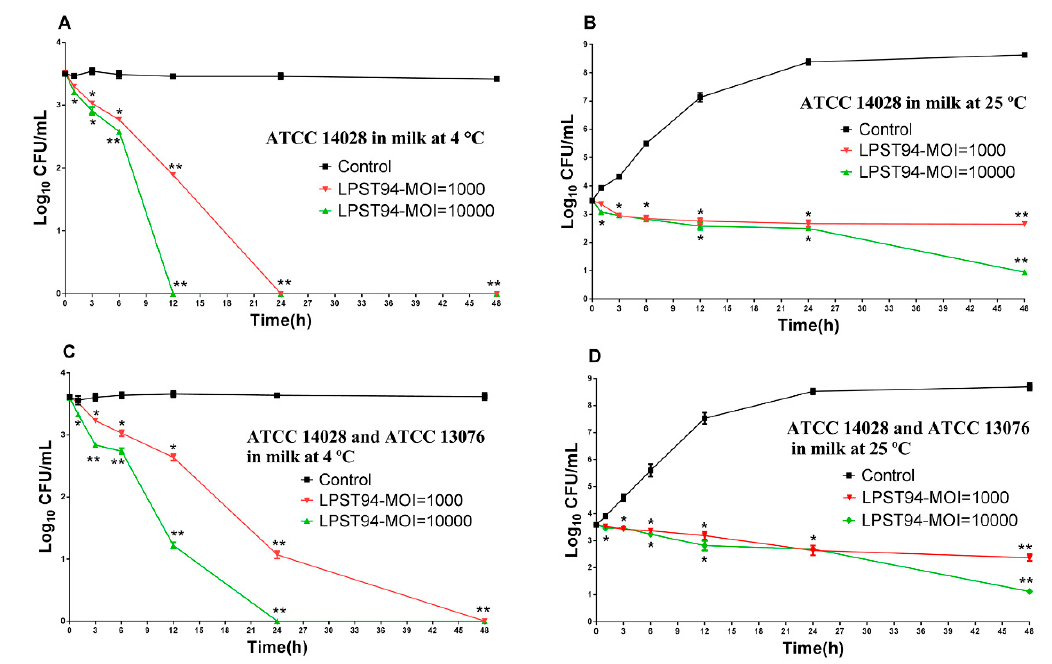
Figure 4. E ff ectiveness of phage LPST94 in reducing the S. Typhimurium ATCC 14028 and S. Enteritidis Figure 4. Effectiveness of phage LPST94 in reducing the S. Typhimurium ATCC 14028 and S. ATCC 13076 in milk. ( A ) E ff ect of phage LPST94 on growth of S. Typhimurium ATCC 14,028 in milk at Enteritidis ATCC 13076 in milk. ( A ) Effect of phage LPST94 on growth of S. Typhimurium ATCC 4 ◦ C, ( B ) E ff ect of phage LPST94 on growth of S. Typhimurium ATCC 14028 in milk at 25 ◦ C, ( C ) E ff ect 14,028 in milk at 4 °C, ( B ) Effect of phage LPST94 on growth of S. Typhimurium ATCC 14028 in milk of phage LPST94 on growth of Salmonella mixture ( S. Typhimurium ATCC 14028 and S. Enteritidis at 25 °C, ( C ) Effect of phage LPST94 on growth of Salmonella mixture ( S. Typhimurium ATCC 14028 ATCC 13076) in milk at 4 ◦ C, and ( D ) E ff ect of phage LPST94 on growth of Salmonella mixture ( S. and S. Enteritidis ATCC 13076) in milk at 4 °C, and ( D ) Effect of phage LPST94 on growth of Salmonella Typhimurium ATCC 14028 and S. Enteritidis ATCC 13076) in milk at 25 ◦ C. Values represent mixture ( S. Typhimurium ATCC 14028 and S. Enteritidis ATCC 13076) in milk at 25 °C. Values